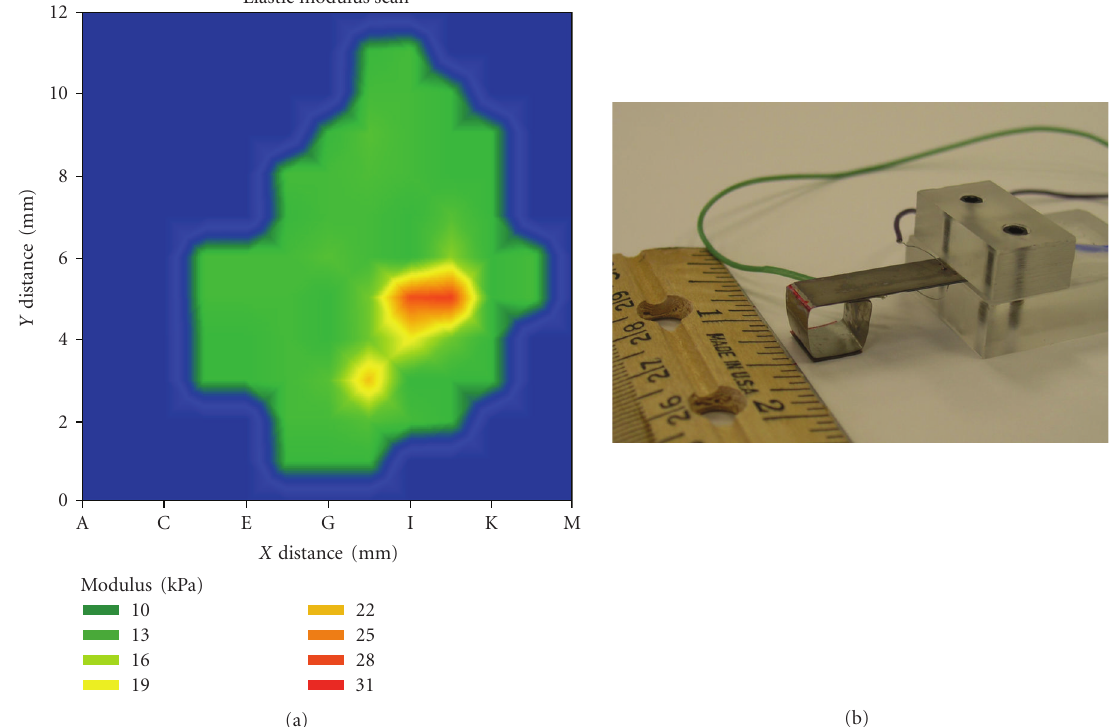
Figure 1: (a) Measured moduli; (b) the piezoelectric finger system. PZT: piezoelectric lead zirconate